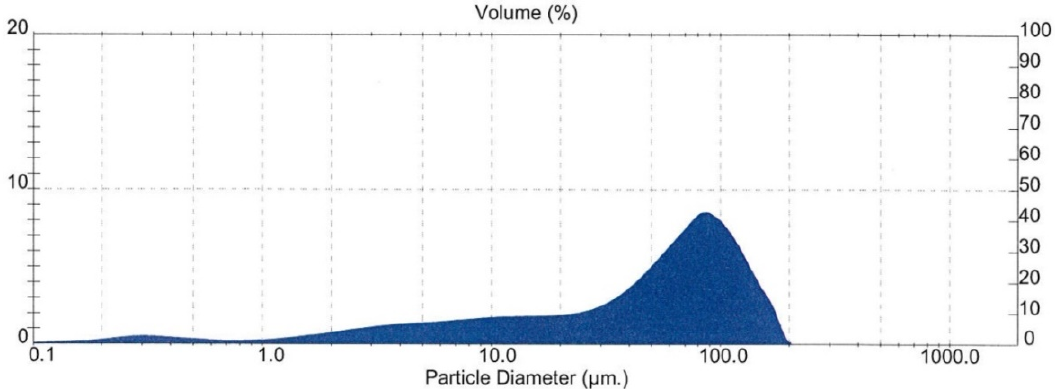
Figure 11. Particle size distribution results for the wet ground RI sample (feed for Flotation Test‒ 4).